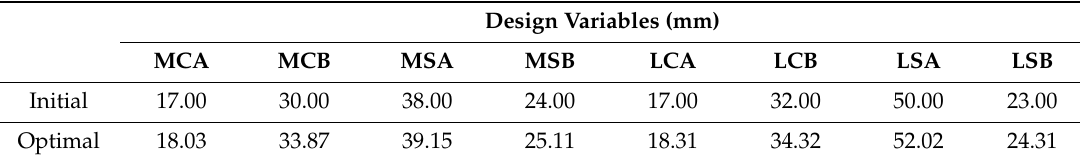
Table 1. Design variables: Initial versus optimal design.